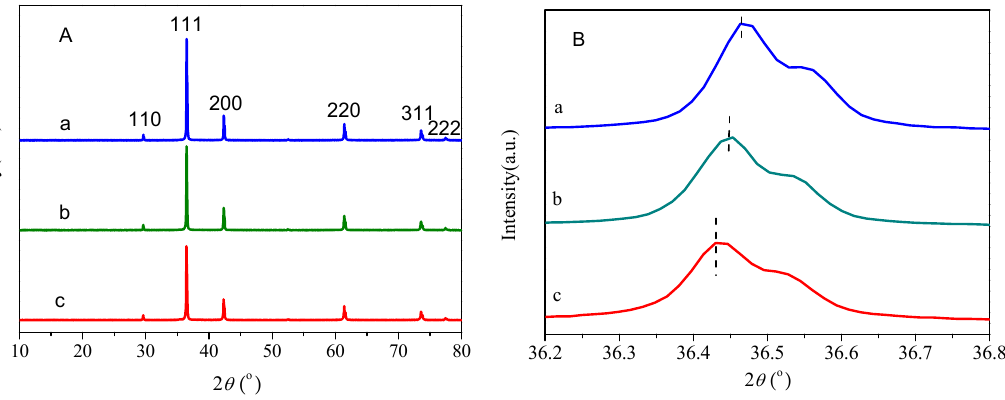
Figure 1. X-ray di ff raction (XRD) patterns of Cu 2 O-NO 3 ( a ), Cu 2 O-Cl(1); ( b ) and Cu 2 O-Cl(2) ( c ). Figure 1. X ‐ ray diffraction (XRD) patterns of Cu 2 O ‐ NO 3 ( a ), Cu 2 O ‐ Cl(1); ( b ) and Cu 2 O ‐ Cl(2) ( c ). (( A ): (( A ): wide angle XRD patterns; ( B ): magnified Cu 2 O (111) di ff raction wide angle XRD patterns; ( B ): magnified Cu 2 O (111) diffraction peak).